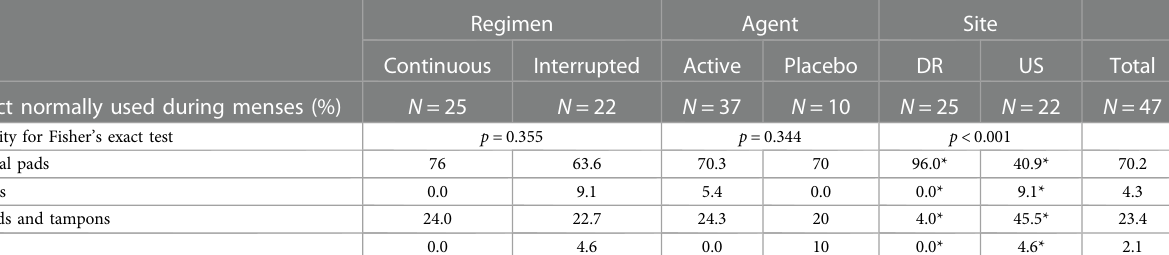
TABLE 1 Menstrual hygiene management, by regimen, agent, and